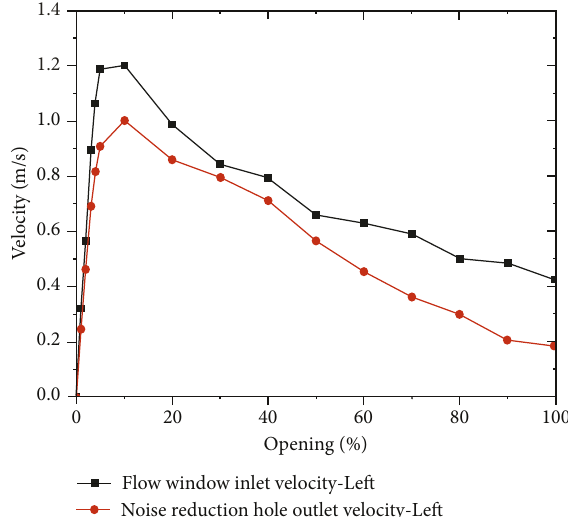
Figure 17: Pressure-opening curve at the inlet and outlet of the left flow window noise reduction orifice.